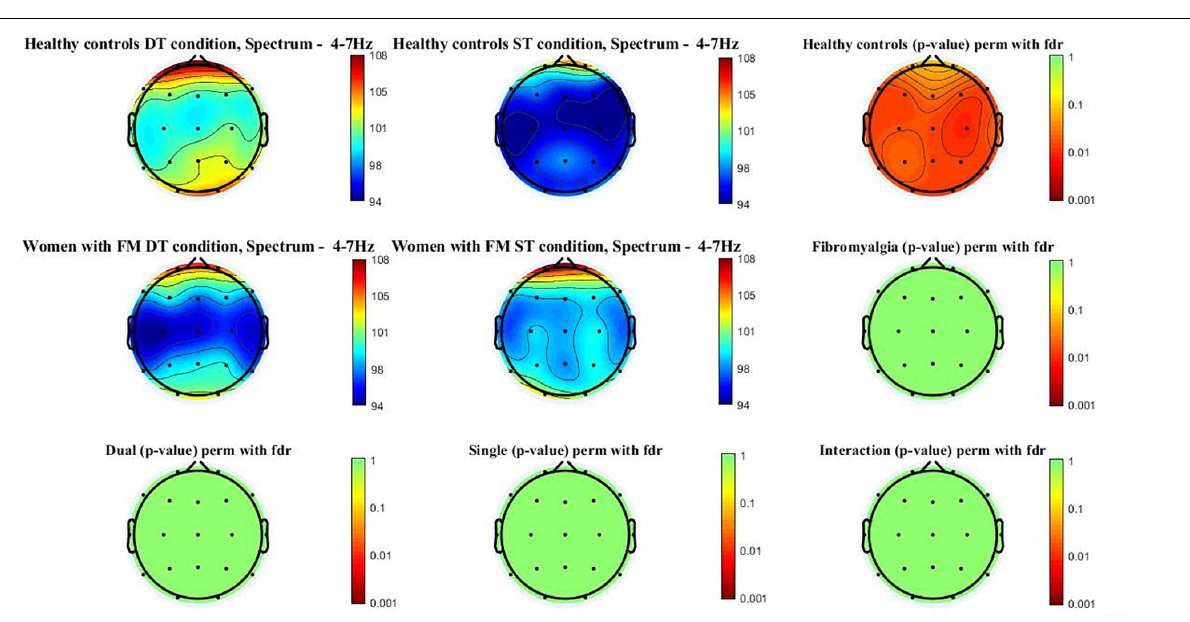
FIGURE 1 | Theta power spectrum (4–7 Hz) topographic maps in women with FM and healthy controls. Differences were only located ( p < 0.05) between ST and DT conditions in healthy controls in the following scalp locations: frontal (Fz, F3, F4, F7, and F8), central (Cz, C3, and C4), temporal (T3, T4, T5, and T6), parietal (Pz, P3, and P4), and occipital (O1 and